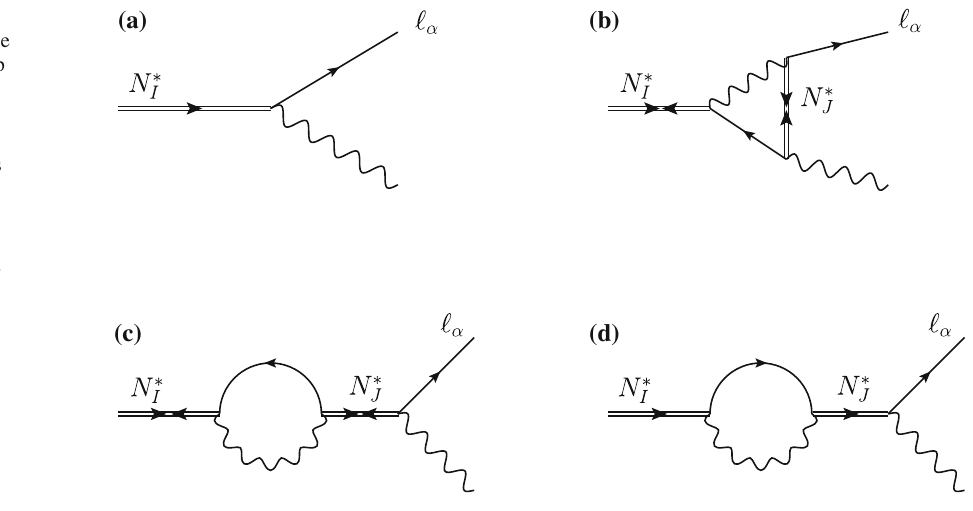
Fig. 3 CP asymmetries originating from the interference between tree-level and one-loop vertex and self-energy (or wave-function) diagrams. Solid double lines stand for heavy composite neutrinos, solid lines for SM leptons and wiggled lines for gauge bosons. The neutrino propagator with forward and forward–backward arrows have the same meaning as in Fig.